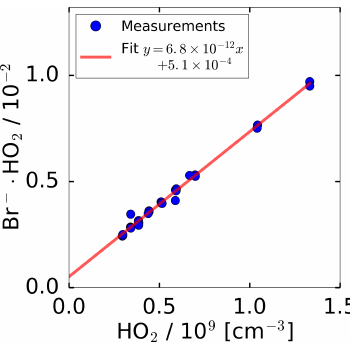
Figure 2. Count rate of HO 2 · Br − ion cluster ( m/z 112) normalised to the primary ion Br − ( m/z 79) during sampling from the HO 2 cal- ibration source. The HO 2 concentration provided by the source was varied by attenuating the radiation of the 185nm radiation used to photolyse water. The water vapour mixing ratio was kept constant. The error bars are smaller than the symbols in the